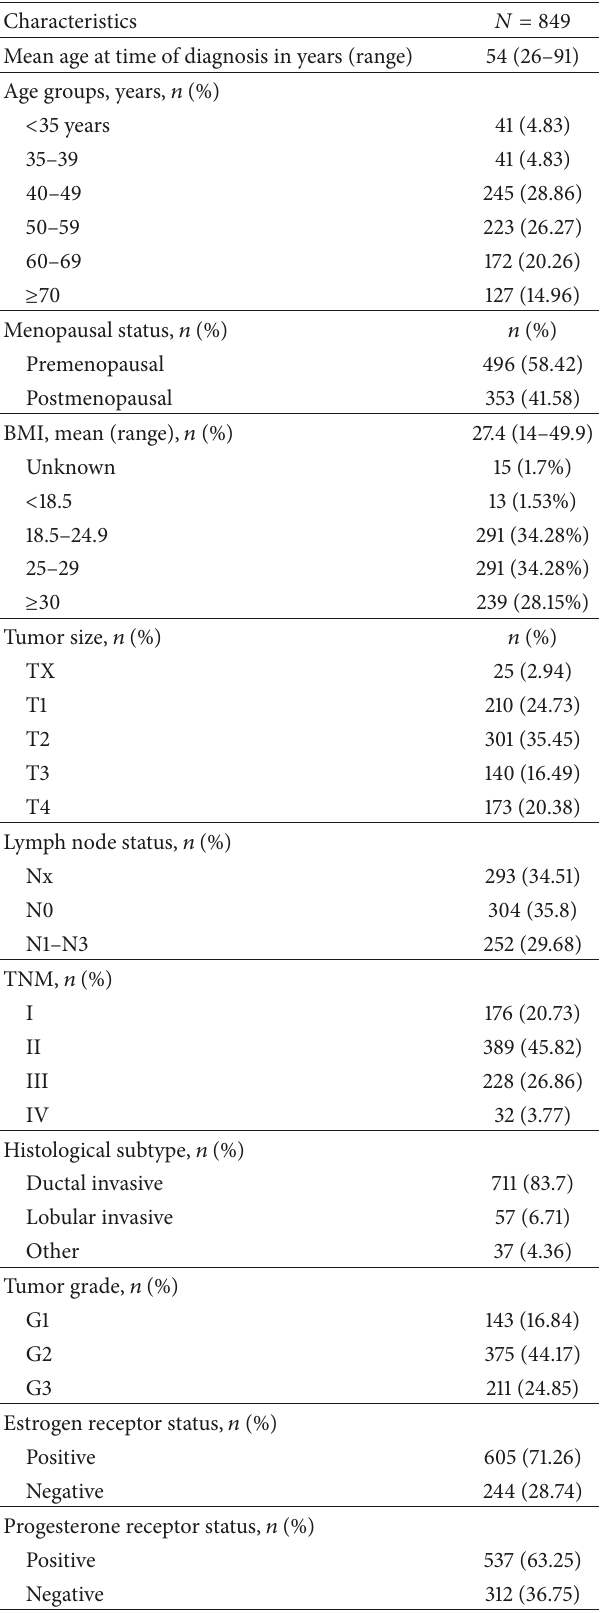
Table 1: Patient demographic and tumor histopathologic character-